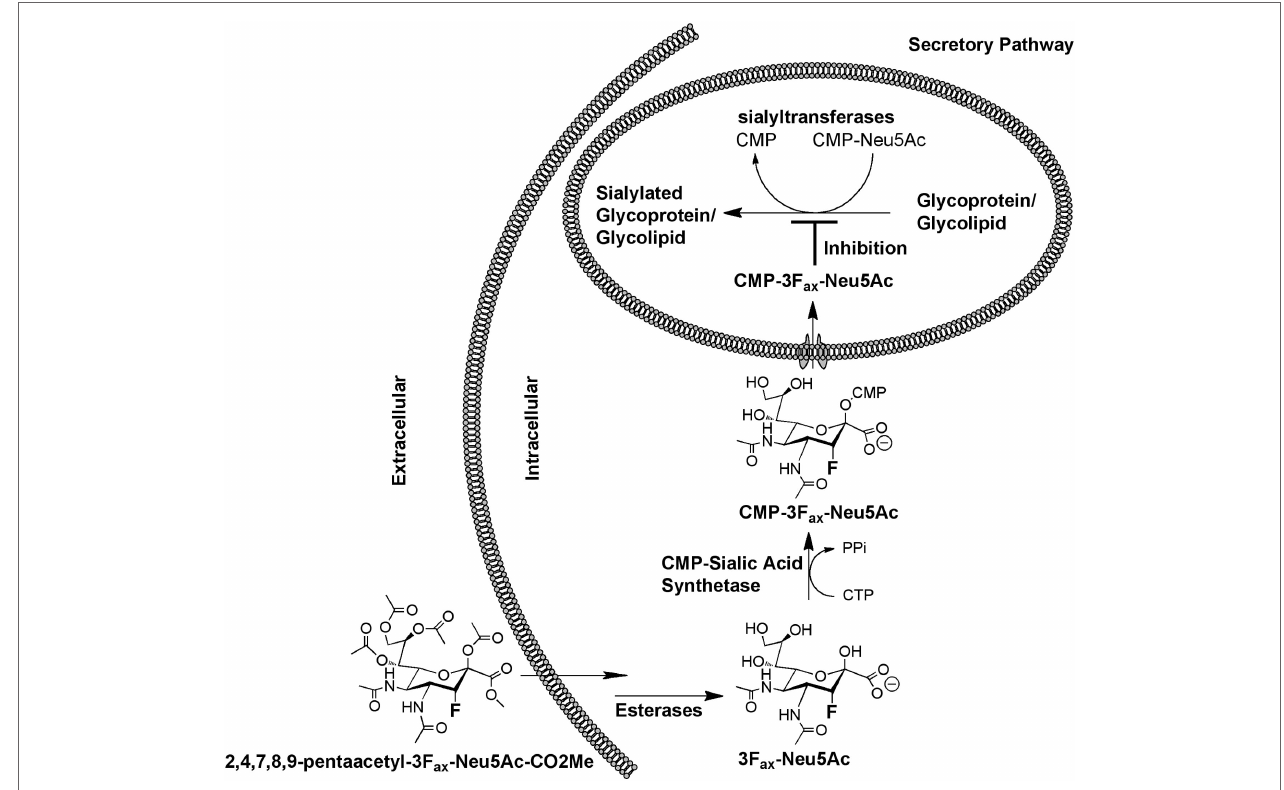
FiGURe 4 | Mechanism of action of the CMP-3F ax -Neu5Ac inhibitor (see text for details)